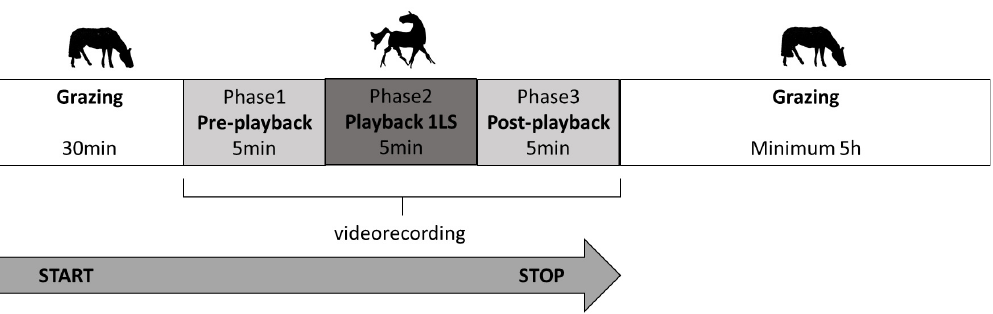
Figure 1. Testing protocol in each trial.